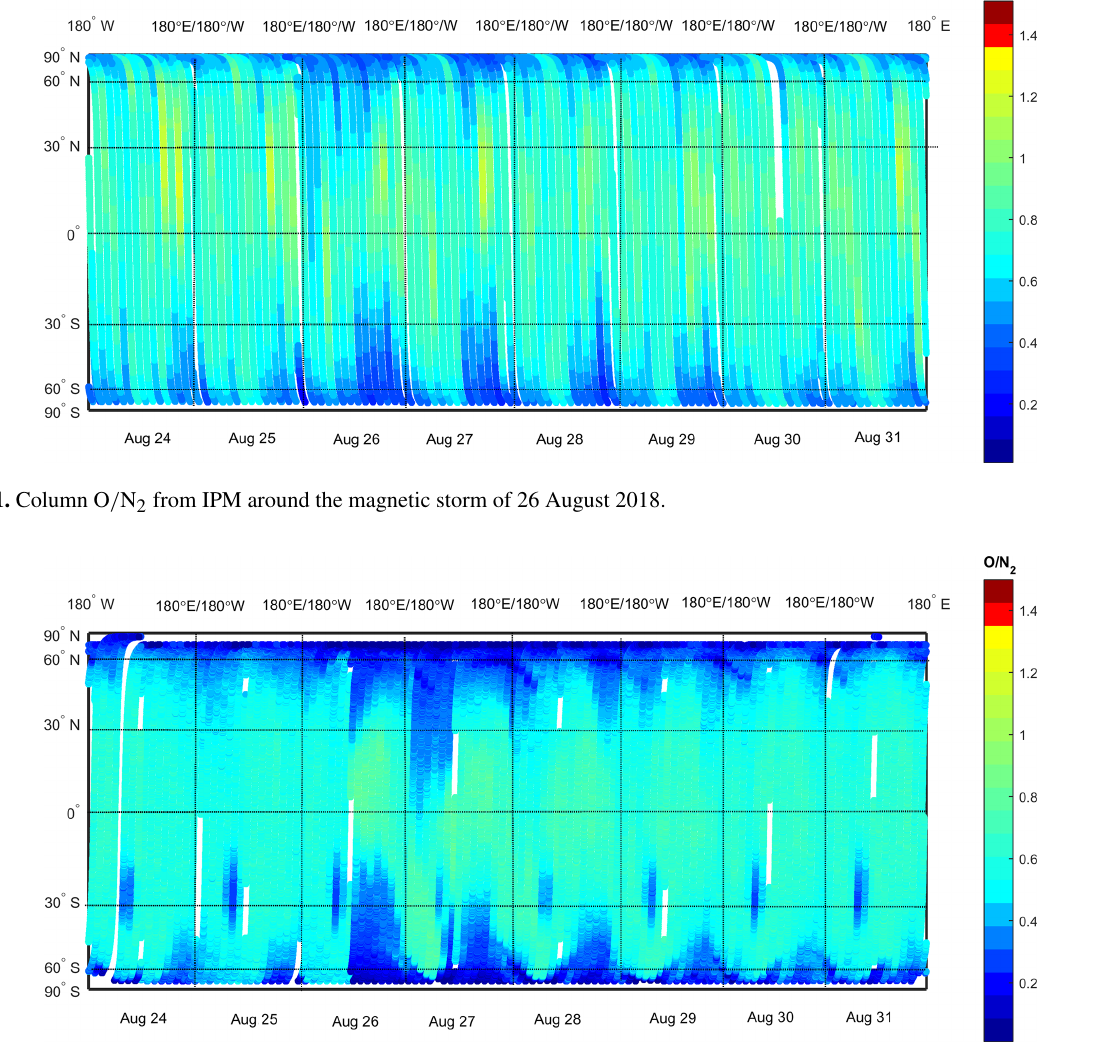
Figure 12. Column O / N 2 from GUVI around the magnetic storm of 26 August